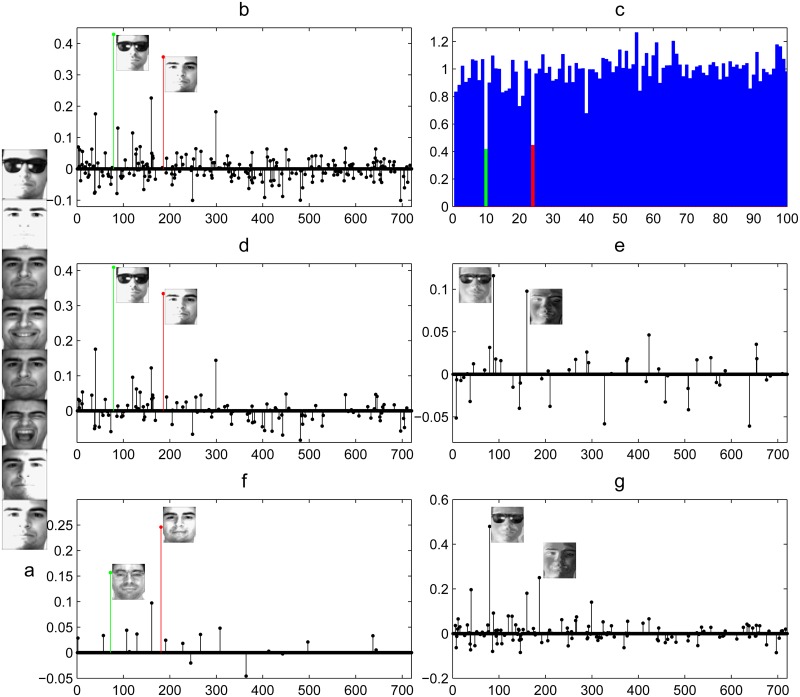
Example of the sparse representation of a query image with disguise (100 subjects).(a) The images from subject 24 in the AR database: the first row is the query image, and the remaining images are training samples of subject 24. (b) The values of the sparse coefficients recovered from SRC are plotted with together the two bases that correspond to the two largest sparse coefficients. (c) Reconstruction residuals with respect to the coefficients for different classes; the red bar indicates the correct class. (d),(e) Illuminate the coefficients solved by ESRC. The sparse coefficients associated with the training sample dictionary and intra-class variant dictionary are plotted in (d),(e), respectively. The coefficients solved by LRSE+SC are shown in (f),(g). (f) Sparse coefficients associated with low rank supervised dictionary. (g) Sparse coefficients associated with sparse intra-class variant dictionary. Red (darker) entry correspond to the base belonging to subject 24 and green (darker) entry correspond to the base belonging to subject 10.